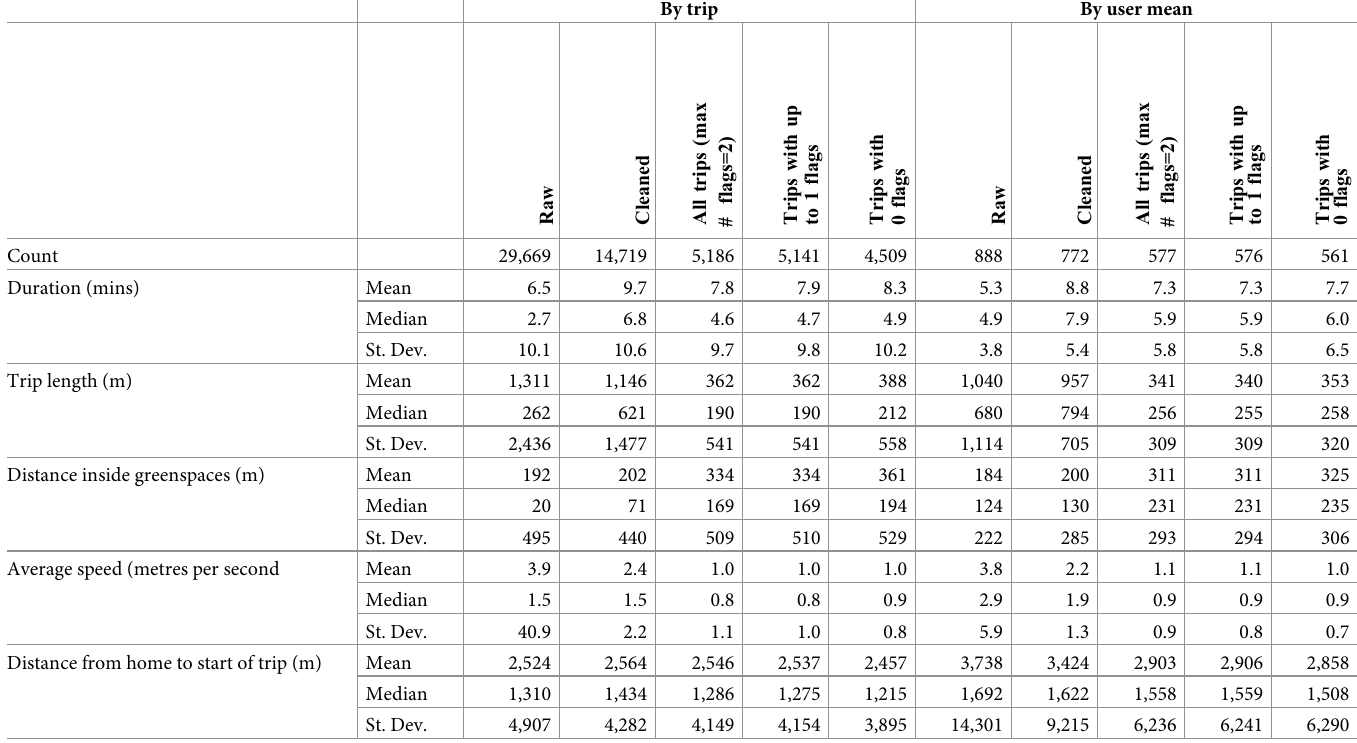
Table 4. Average characteristics of trips relating to visits to greenspace—pre-processing; following cleaning; and following post-processing (with any number of flags highlighting potentially problematic trip features; 0 or 1 flags; and 0 flags). Characteristics shown as averages across all trips, and as averages of by-user means. By trip By user mean